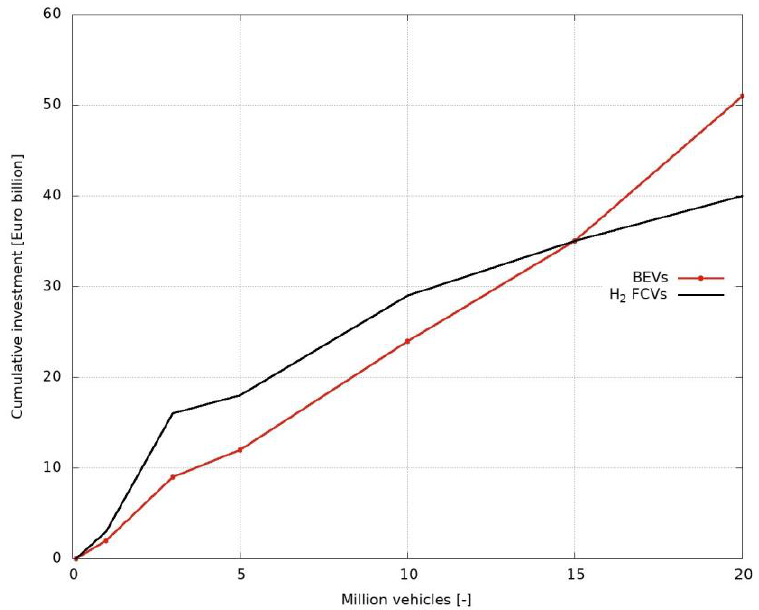
Figure 15. Comparison of the cumulative investment of supply infrastructures [26].